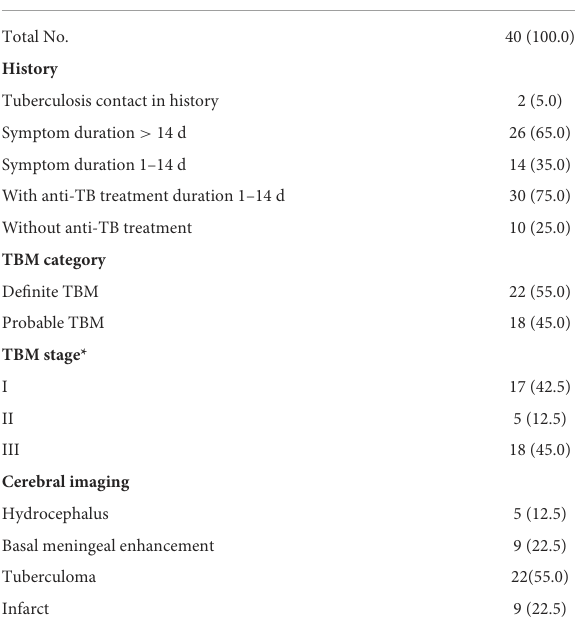
TABLE 2 Characteristics of patients with TBM # .